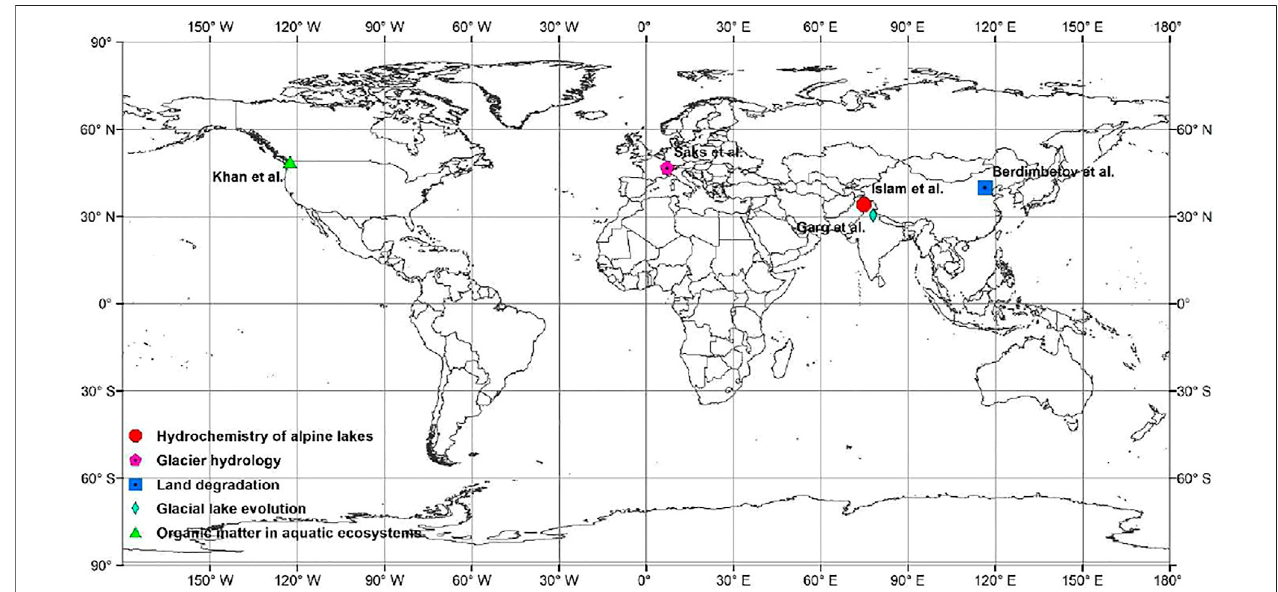
FIGURE 1 | Topical and geographical distribution of contributions in this research